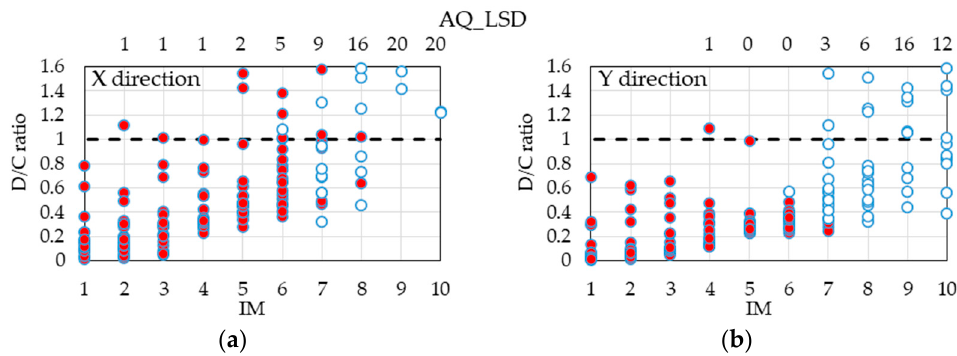
Figure 15. Displacement D/C ratios of the superstructure (UPD): AQ_LSD X ( a ) and Y ( b ) direc- tions.